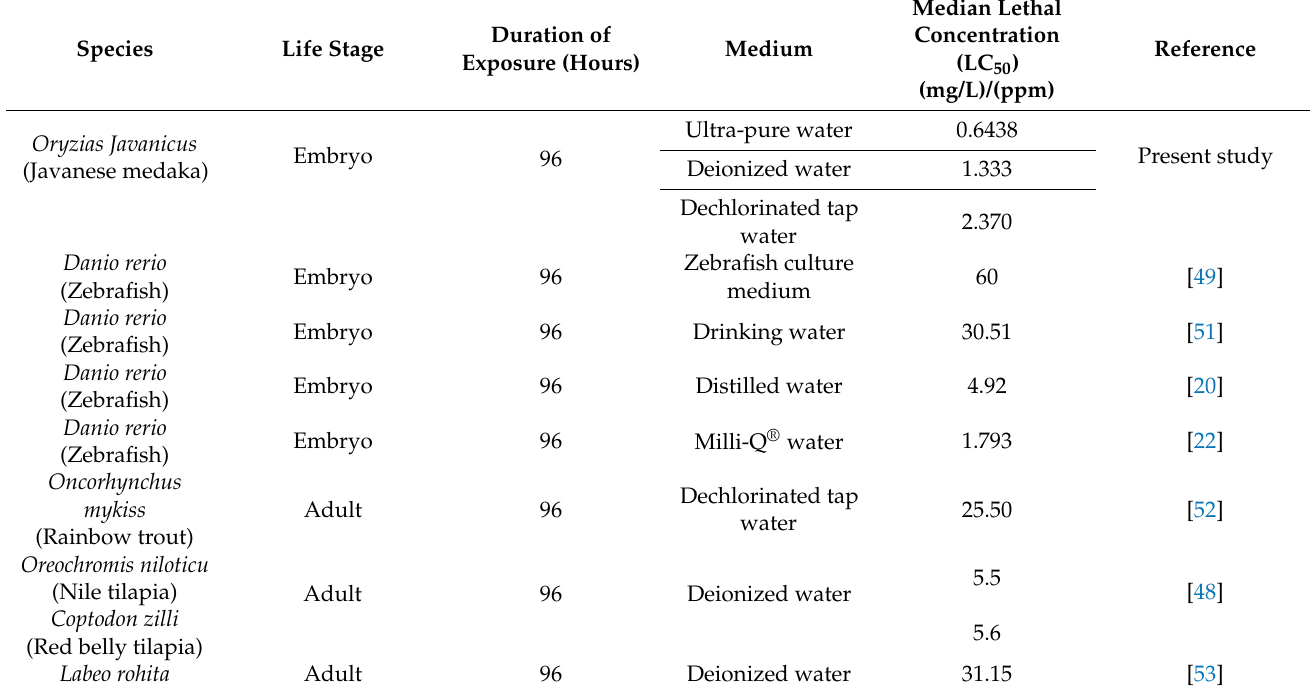
Table 2. Acute toxicity of ZnO NPs on different species of